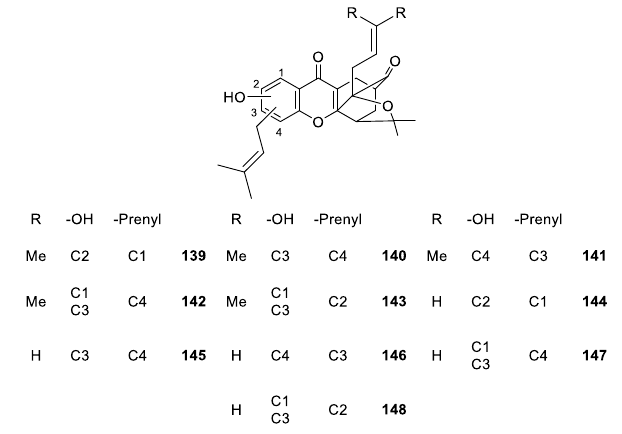
Figure 12. Structures of caged xanthones 124 – 138 , with antitumor activity.